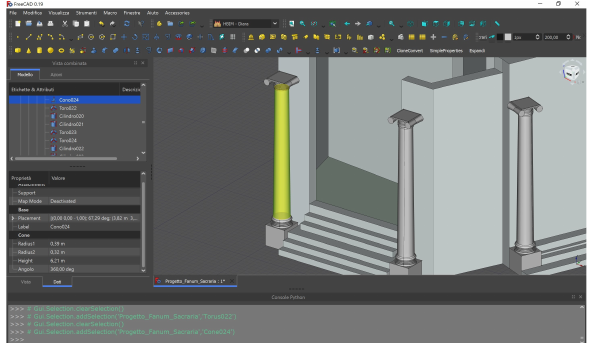
Figure 6 . Detail on parametric cone related to the shaft of the ionic column on the